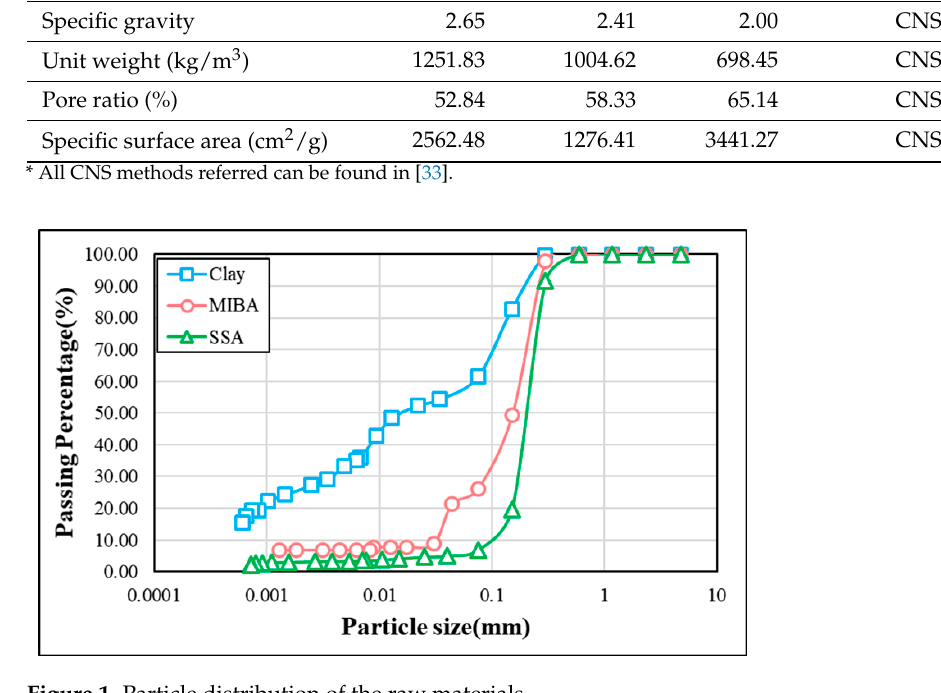
Figure 1. Particle distribution of the raw materials